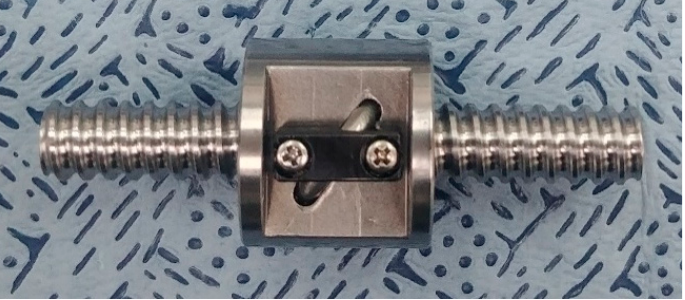
Table 1. Geometric parameters of ball screw.